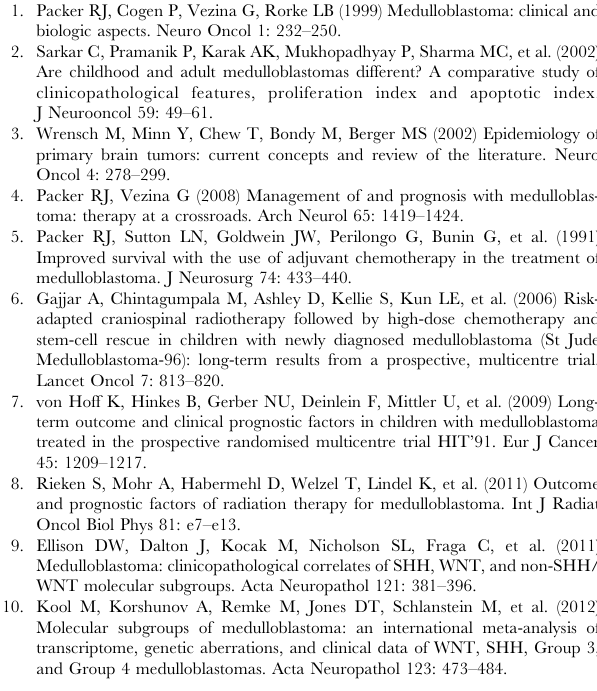
Figure 2. Univariate analysis of overall survival (OS) and event-free survival (EFS) of histological and molecular subgroups of medulloblastoma. a–d: OS and EFS analysis in classic medulloblastoma (CMB, dark red) according to postoperative radiation therapy (RT) and chemotherapy (CHT). e–h: OS and EFS analysis in desmoplastic/nodular medulloblastoma (DMB, grey) according to postoperative RT and CHT. i–l: OS and EFS analysis in SHH medulloblastoma (red) according to postoperative RT and CHT. m–p: OS and EFS analysis in WNT medulloblastoma (green) according to postoperative RT and CHT. q–t: OS and EFS analysis in Non-SHH/WNT medulloblastoma (yellow) according to postoperative RT and CHT. Numbers on the Y axis indicate probability of survival in medulloblastoma patients. Numbers of the X axis indicate the follow-up time